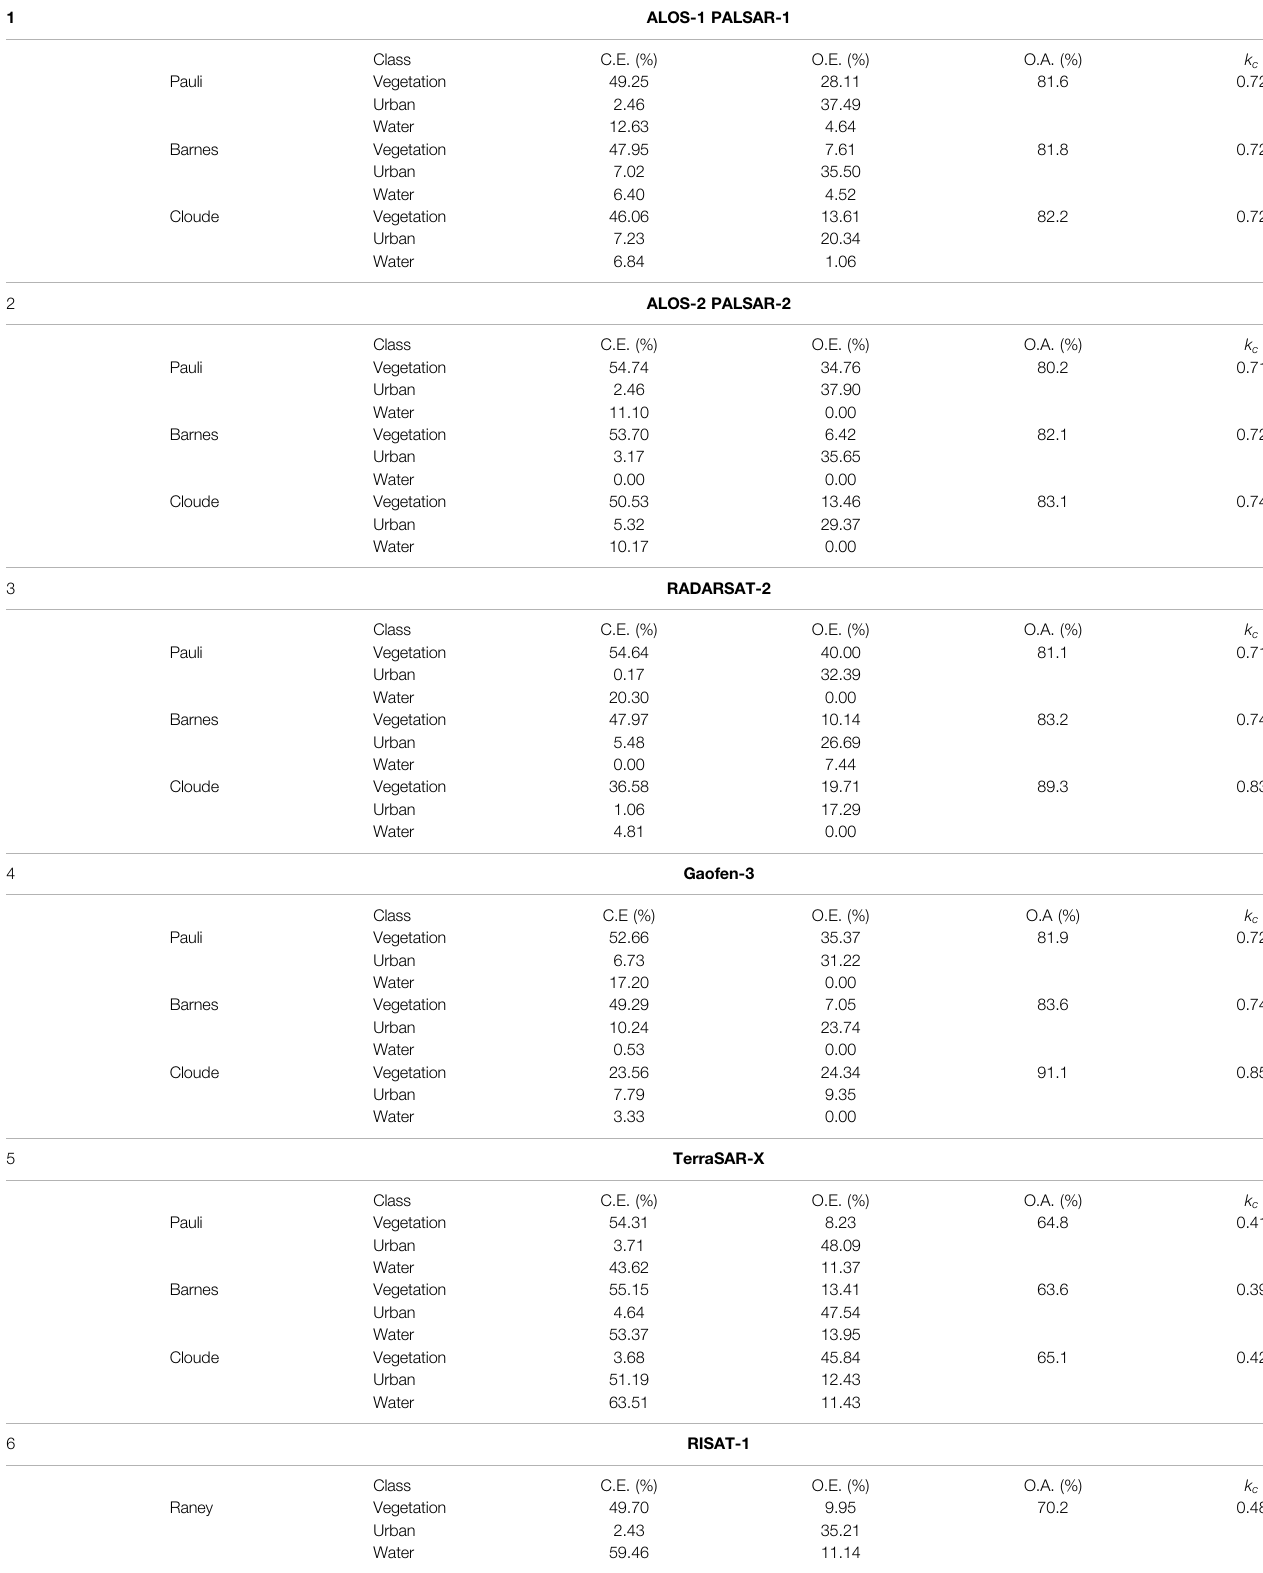
TABLE 3 | Overall Accuracy (O.A), kappa coef fi cient ( k c ), commission (C.E.), and omission error (O.E.) of LULC images displayed in Figure 10